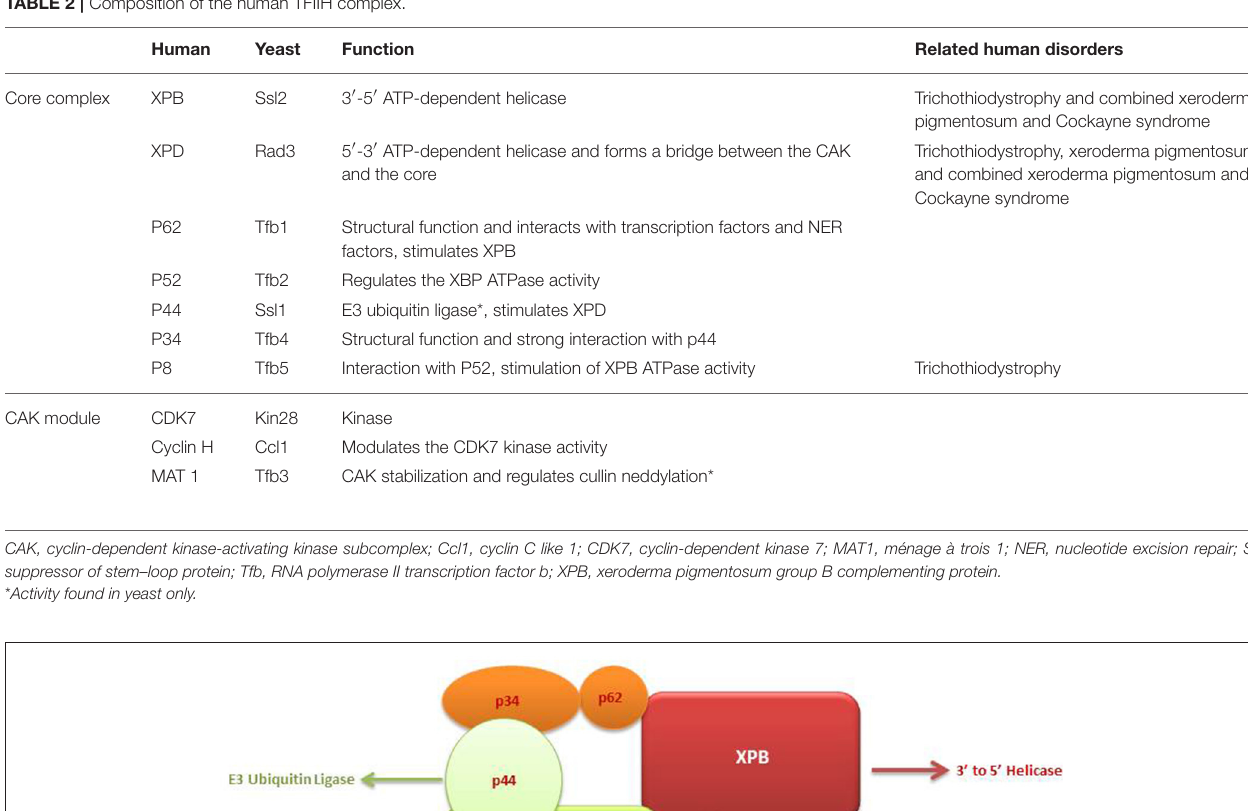
TABLE 2 | Composition of the human TFIIH complex.